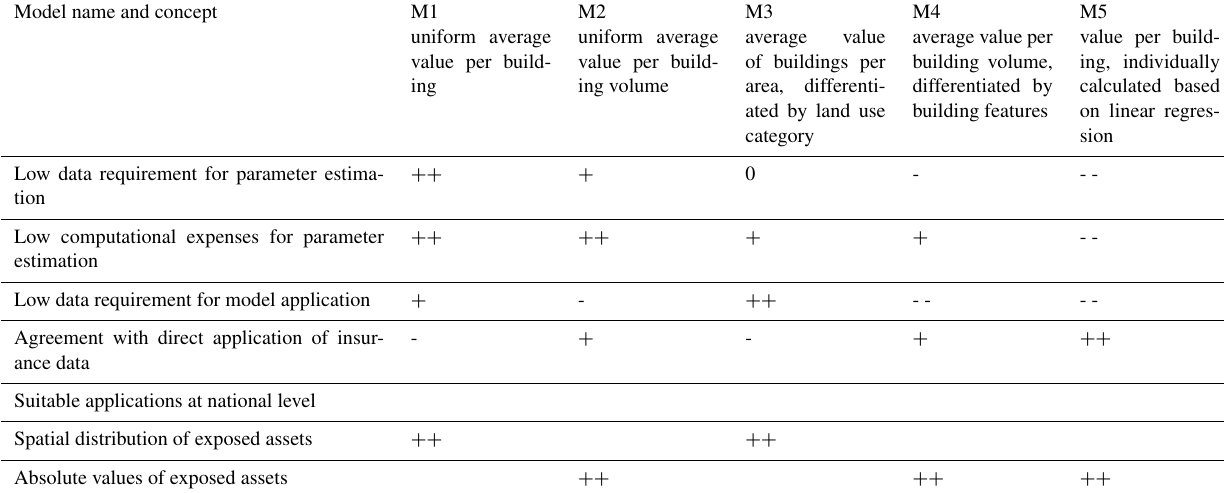
Table 8. Overview of core features and suitable applications of the five models. Symbols of characteristics: + is positive, 0 is neutral and minus is negative. The key figure in the online version of the article is a graphical version of this